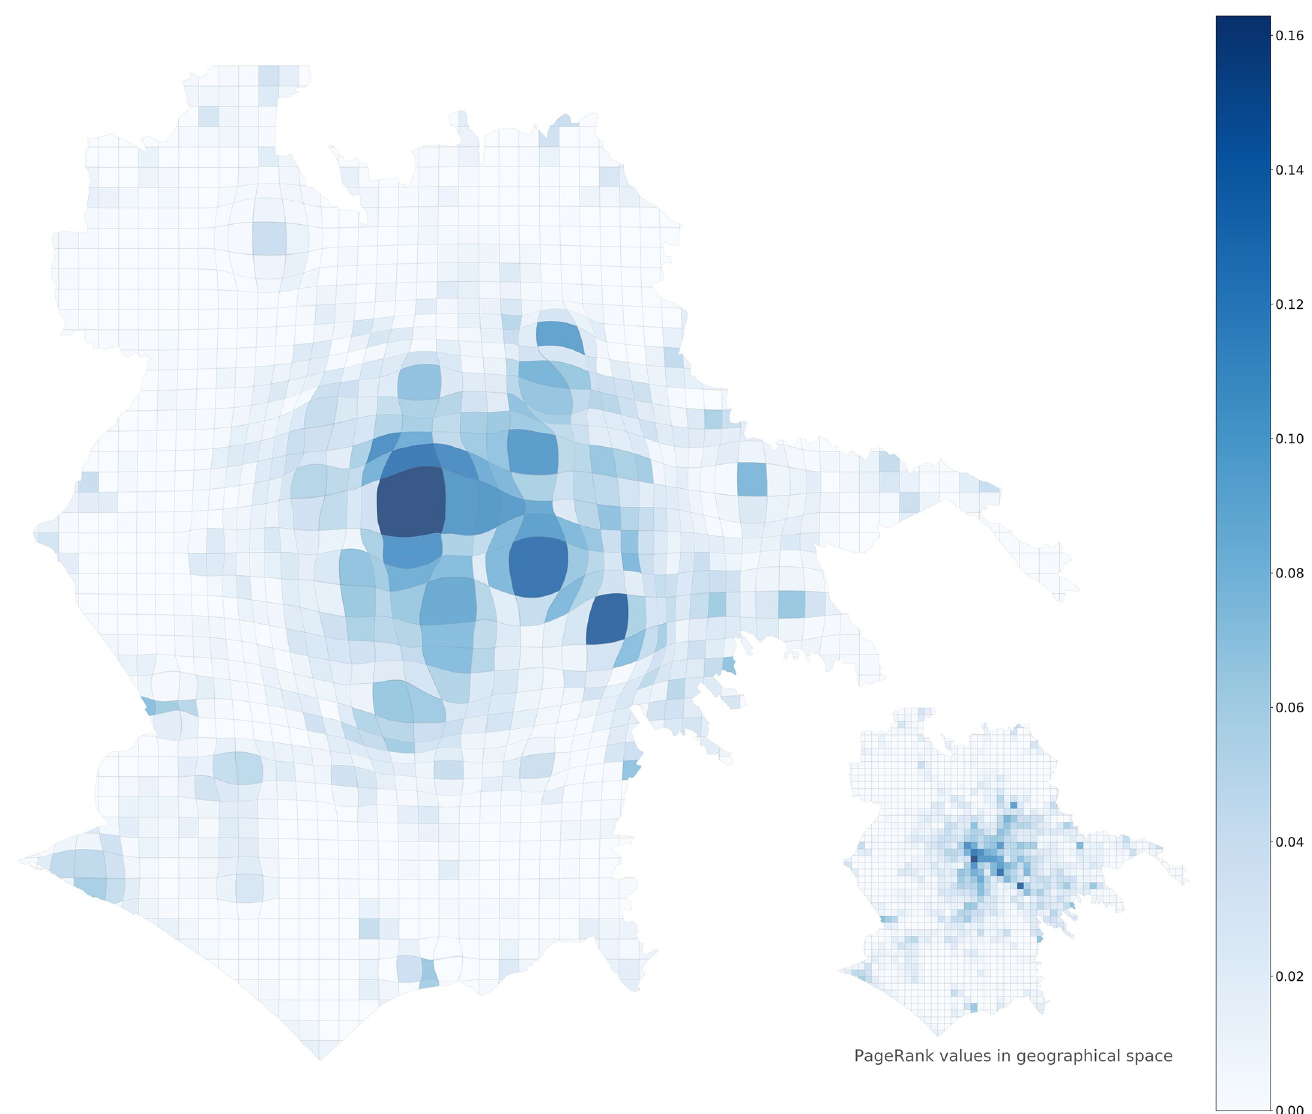
Fig 15. Tracking the difference TSI ð ~ x � Þ (cid:0) Z ð ~ x � Þ in Rome and London during a typical day.